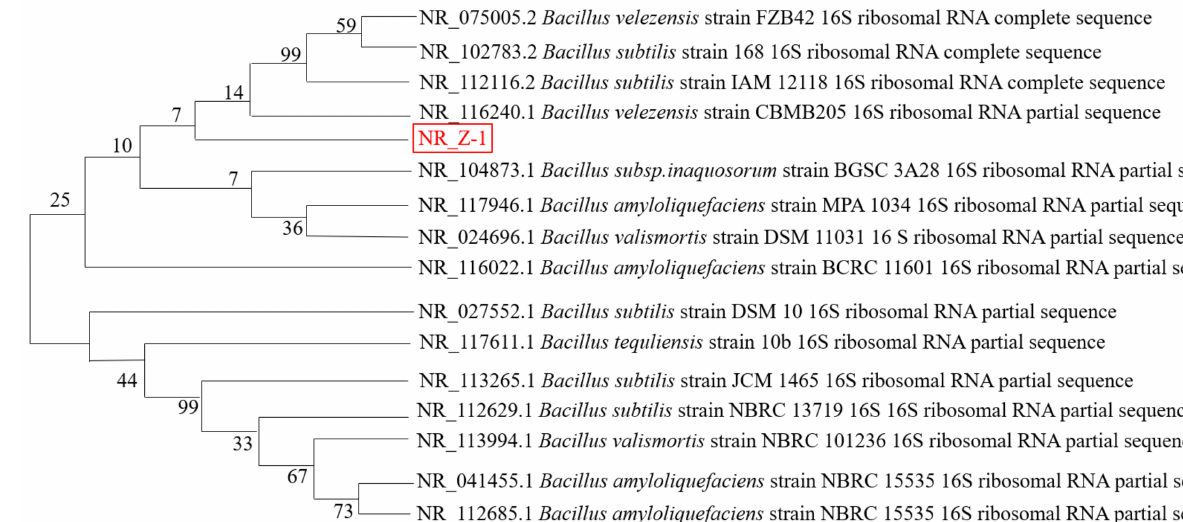
Figure 2. Phylogenetic tree of strain Z-1 constructed based on 16S